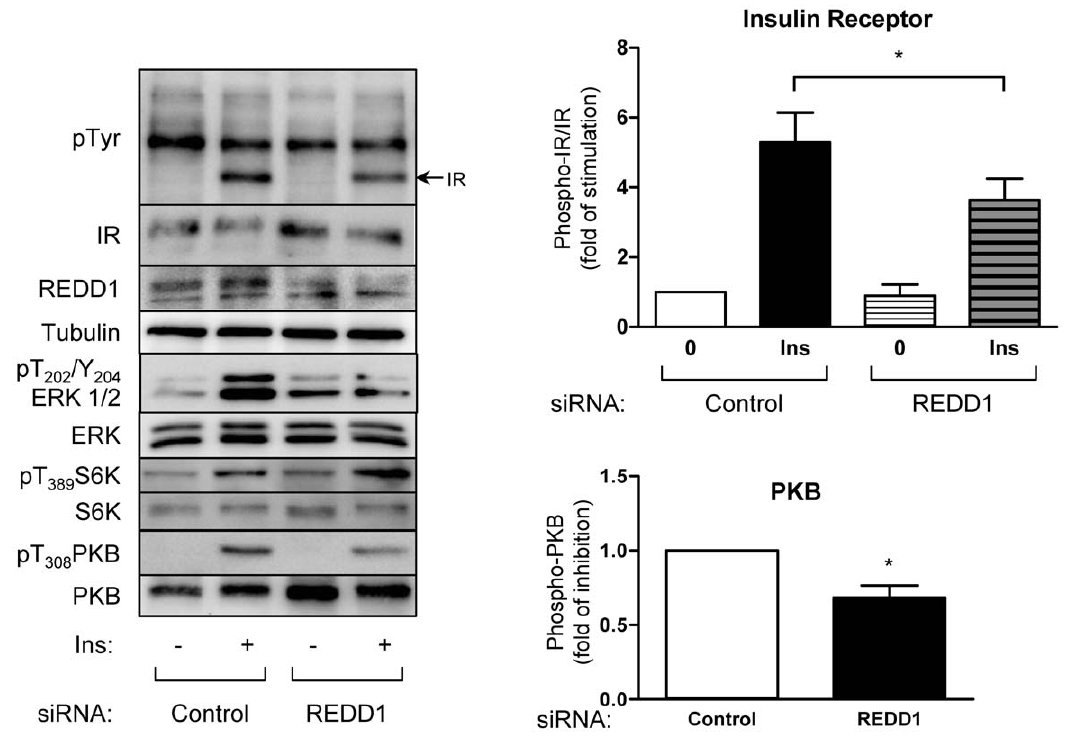
Figure 6. Downregulation of REDD1 expression inhibits insulin signaling pathway in 3T3-L1 adipocytes. 3T3-L1 adipocytes were transfected with REDD1 siRNA 48 h after transfection, adipocytes were stimulated with insulin (10 nM) for 5 minutes. Proteins were analyzed by immunoblots using indicated antibodies. Quantification of phosphorylation of insulin receptor (n=6) and PKB (n=5) in response to insulin is shown (*p , 0.05).